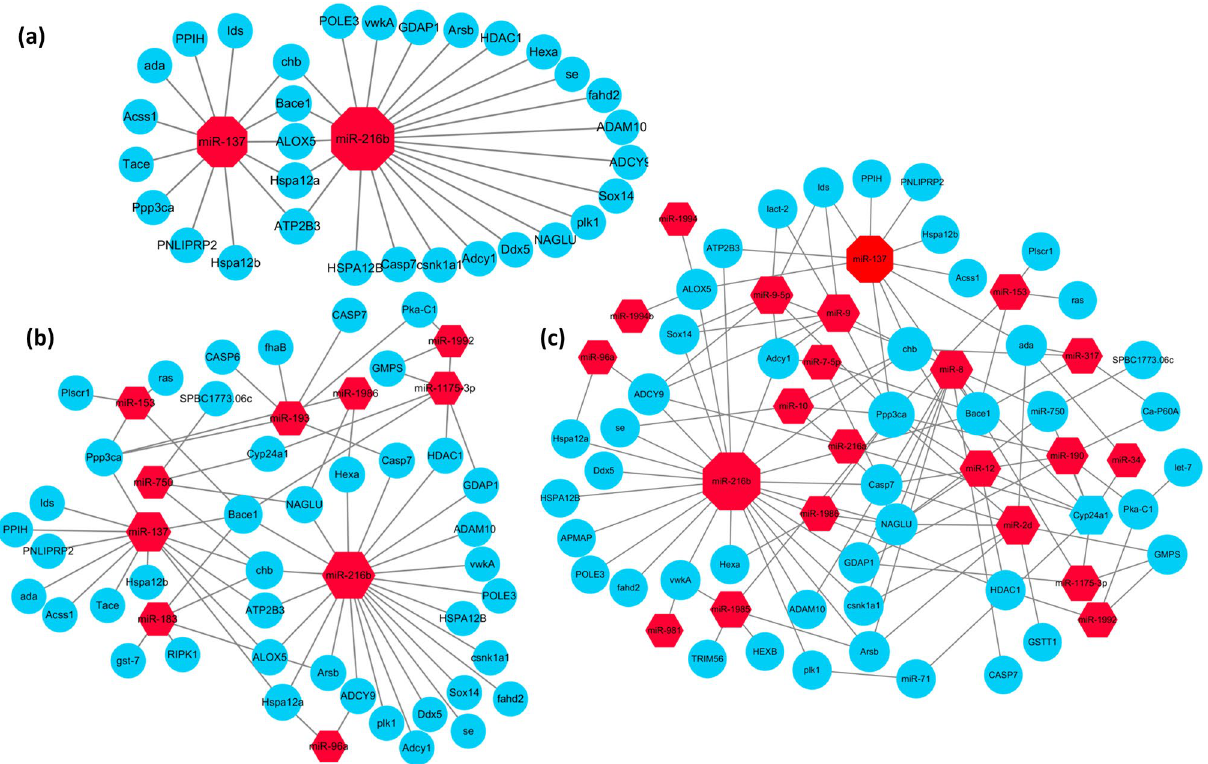
Figure 4. Potential regulatory networks between DEMs and their target genes. ( a ) Wh vs Or, ( b ) Wh vs Zs, ( c ) Or vs Zs. The regulation network of miRNAs and their target genes was illustrated by Cytoscape software. Red Hexagons and blue circles represent miRNAs and target genes,